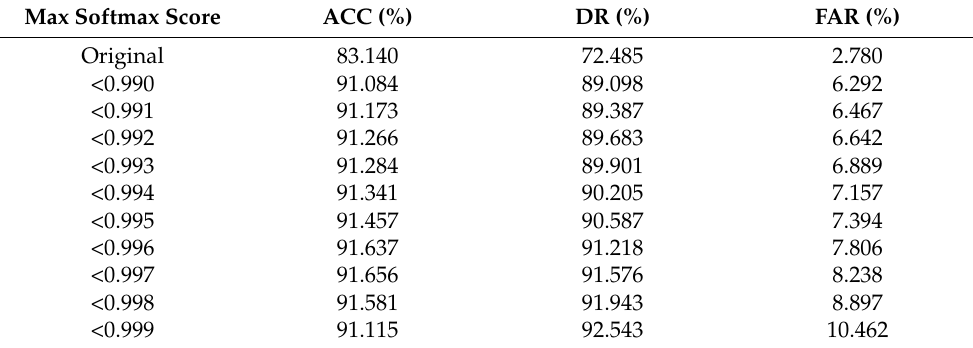
Table 4. The result of the